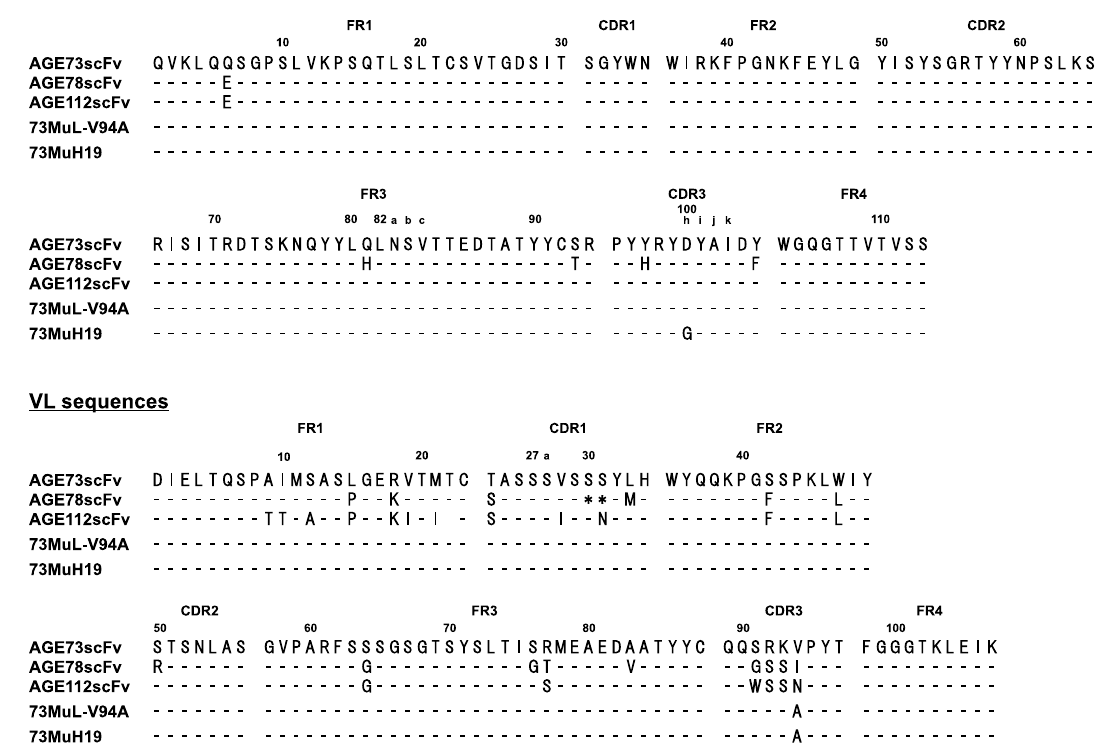
Figure 3. Amino acid sequences of the VH and VL of scFv clones selected by phage display. AGE73scFv, AGE78scFv, and AGE112scFv were obtained from the GA-KLH immunized mouse antibody library, which exhibited a positive response for GA-BSA in phage ELISA. 73MuL-V94A from the second library, and 73MuH19 from the third library were selected. Amino acid sequence differences are indicated; those that are conserved between the proteins are denoted by dashes.